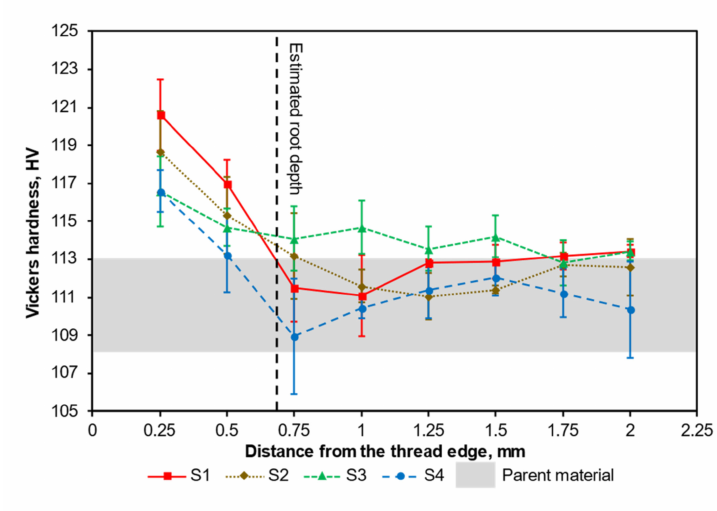
Figure 8. Average hardness values in the mid-section from the thread surfaces for all scenarios. The error bars indicate the standard errors. The characteristic length of the M8 × 1.25 thread root is indicated by the vertical dashed line.